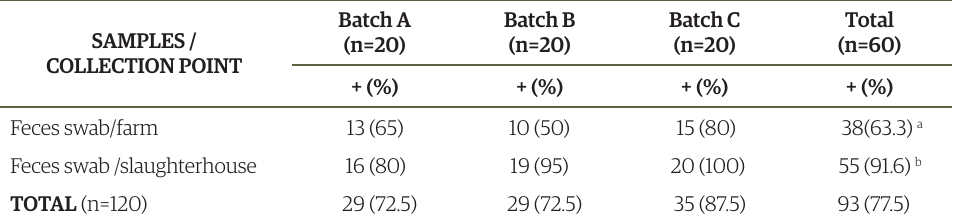
Table 1. Positivity to Campylobacter spp. in feces samples collected on the farm and at the slaughterhouse in three different batches of finishing